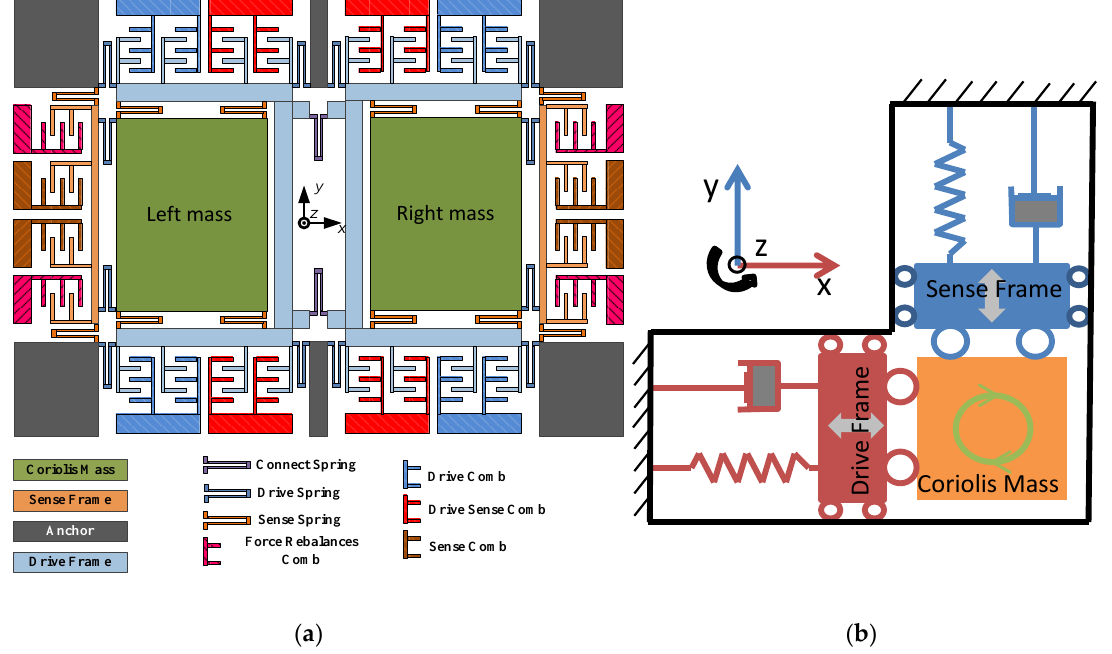
Figure 1. Dual-mass MEMS gyroscope structure ( a ) and its mechanical model ( b ).